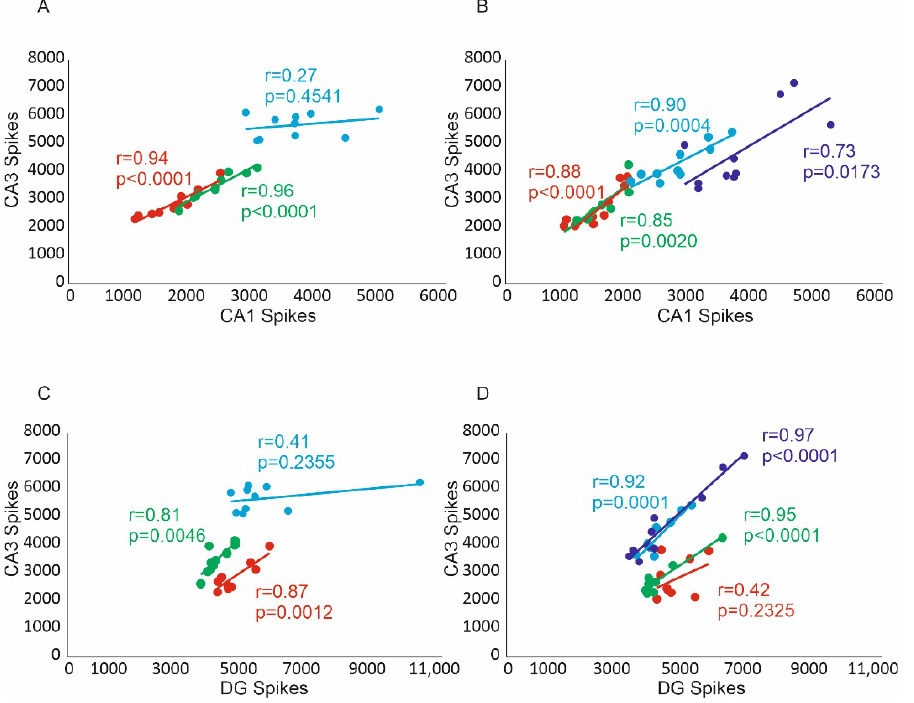
Figure 3. The correlation analysis of the number of spikes and CA1, CA3 and DG regions in virtual therapy of memantine treatment at three concentrations: 3 µM, 10 µM and 30 µM of CA1 region (red —AD, green—3 µM , blue —10 µM and violet—30 µM ). Information in the hippocampus flows in the direction of DG → CA3 → CA1. The flow of information in CA3 → CA1 ( A , B ) and DG → CA3 ( C , D ). Relationships between number of spikes CA3, CA1 regions and DG, CA3 regions. ( A ) CA1 and CA3 of moderate AD, ( B ) CA1 and CA3 of severe AD, ( C ) DG and CA3 of moderate AD, ( D ) DG and CA3 of severe AD.